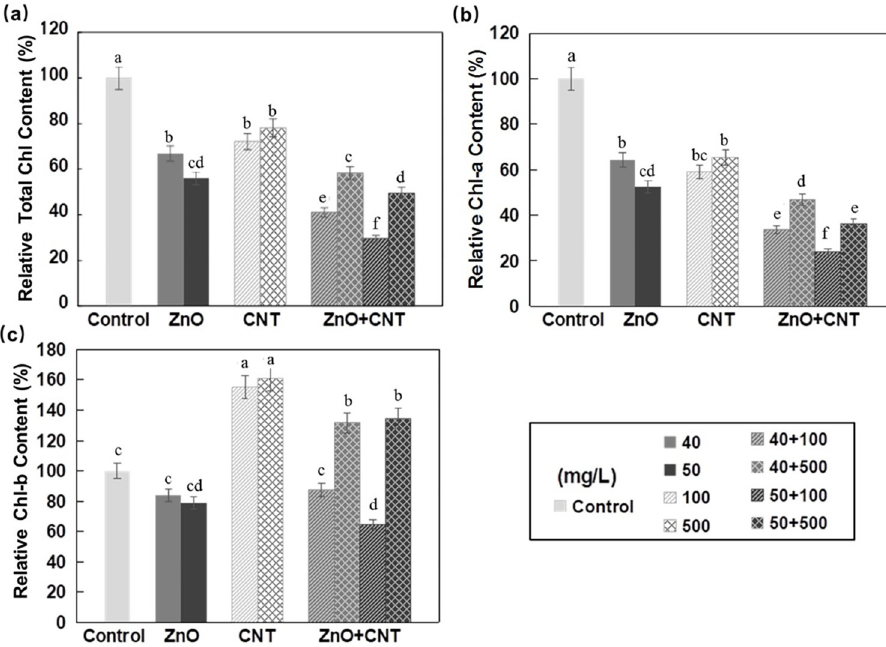
Fig 2. Effects of ZnO NPs and MWCNTs, alone or in combination, on chlorophyll content of Arabidopsis seedlings at 10 DAG. (a) Relative total chlorophyll content. (b) Relative chlorophyll-a content. (c) Relative chlorophyll-b content. ½ MS medium without NPs was used as control. Data are the means ± standard errors of three replicates. Different letters indicate a significant difference between treatments ( P < 0.05, Duncan test).